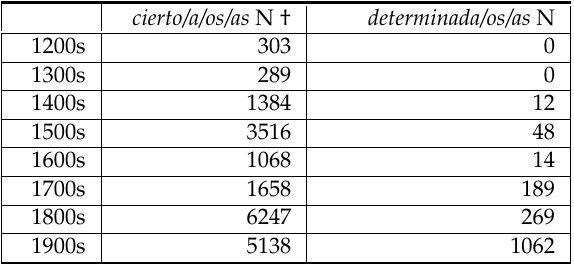
Table 6. “Introductory” determiners in Castilian in CdE (raw